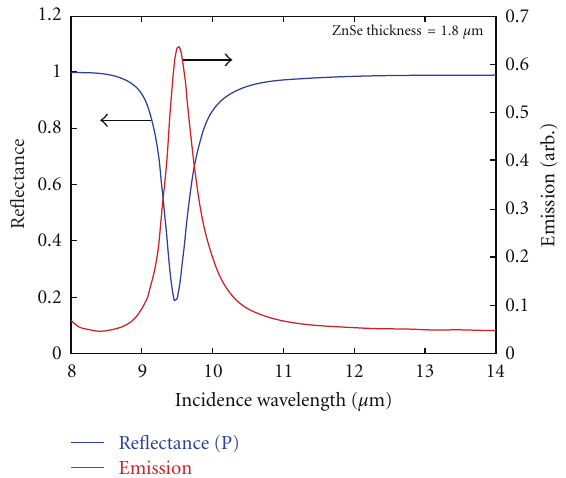
Figure 12: Experimentally measured reflectance curve and emis- sion curve clearly demonstrating the resonant nature of our